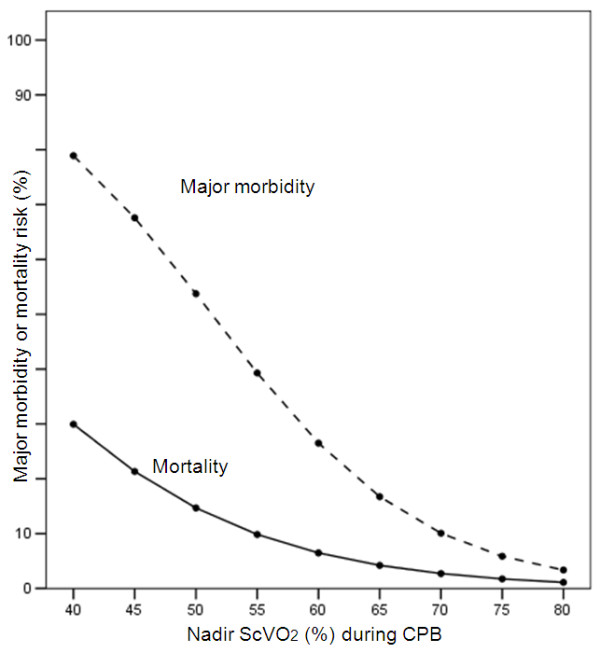
Predicted major morbidity and mortality rates (logistic regression analysis) according to the nadir ScVO2 value, for a cardiopulmonary bypass (CPB) duration of 90 minutes.